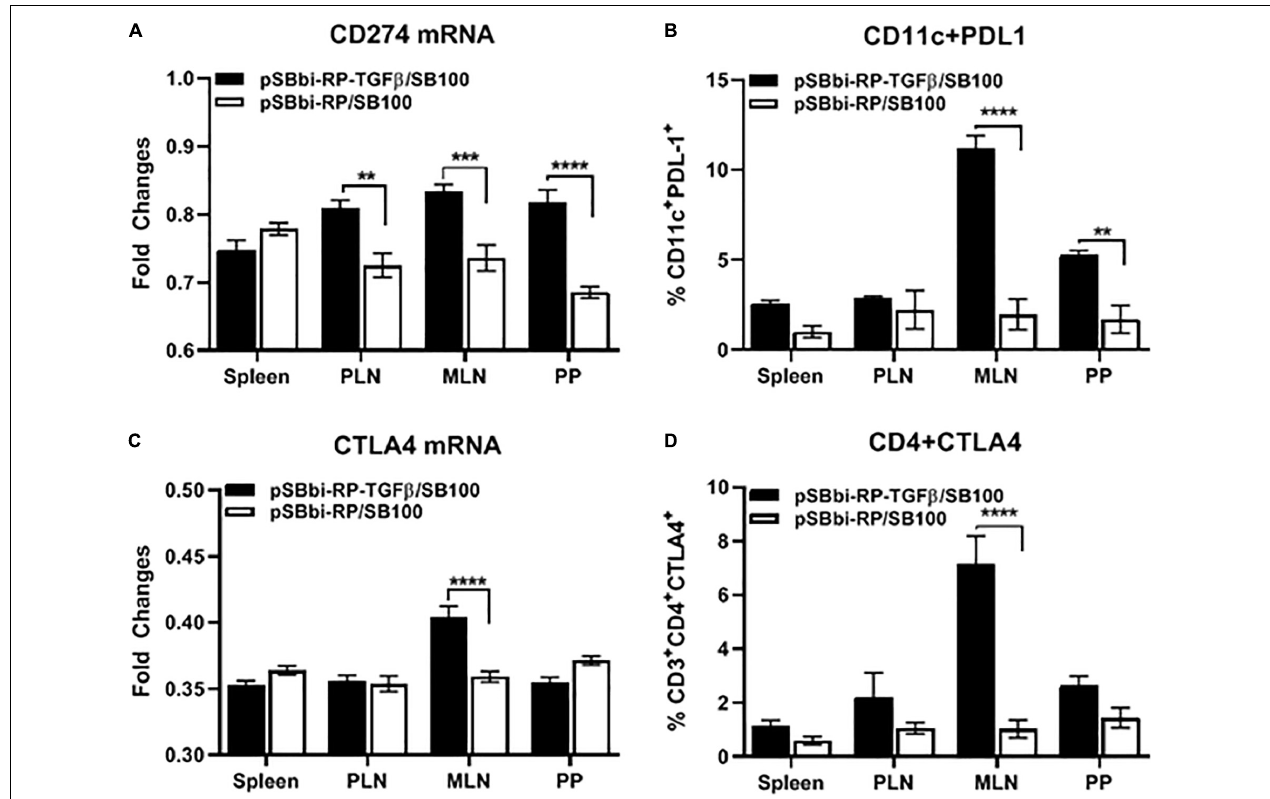
FIGURE 5 | Endogenous TGF β alters PDL-1 and CTLA4 expression in secondary lymphoid tissues. NOD mice were given a single oral dose of Salmonella (pSBbi-RP-TGF β /SB100) or Salmonella (pSBbi-RP/SB100). Four weeks post-vaccination, the fold changes in gene expression of (A) CD274 (PDL-1) in sorted CD11c cells and (C) CTLA4 in sorted CD4 cells isolated from specified organs was determined. Percentage of CD11c + cells expressing PDL-1 (B) or CD4 + cells expressing CTLA4 (D) were quantified in the spleen, PLN, MLN, and PP. The data shown are the average with SD from two independent experiments. Statistical analysis using two-way ANOVA shows significance between Salmonella (pSBbi-RP-TGF β /SB100) and Salmonella (pSBbi-RP/SB100) groups (** p < 0.01, *** p < 0.001, **** p < 0